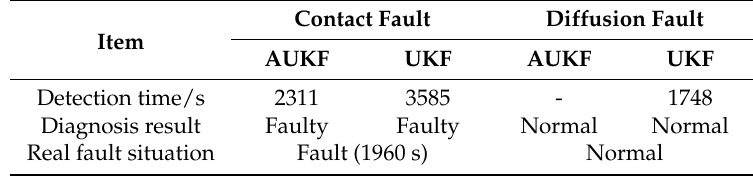
Table 3. Diagnosis Result of Slow-Varying-Type Fault.